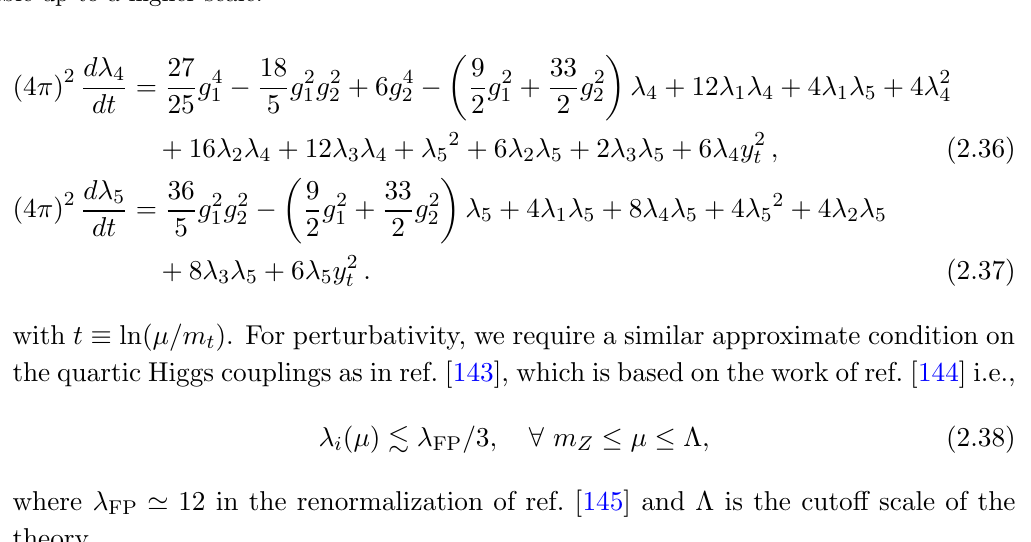
Figure 1 . Left panel: tree-level vacuum stability (green region) and perturbative unitarity (orange region) constraints on the (cid:21) 4 - (cid:21) 5 plane with (cid:21) 2 = 0 : 2 and (cid:21) 3 = 0. Right panel: one-loop running of the Higgs quartic couplings at (cid:21) 2 = 0 : 2, (cid:21) 3 = 0, (cid:21) 4 = 0 and (cid:21) 5 = (cid:0) 0 : 1 with M t = 173 : 1 GeV being our input scale. The black arrow in the left (cid:12)gure corresponds to regions in which vacuum stability is stable up to a higher